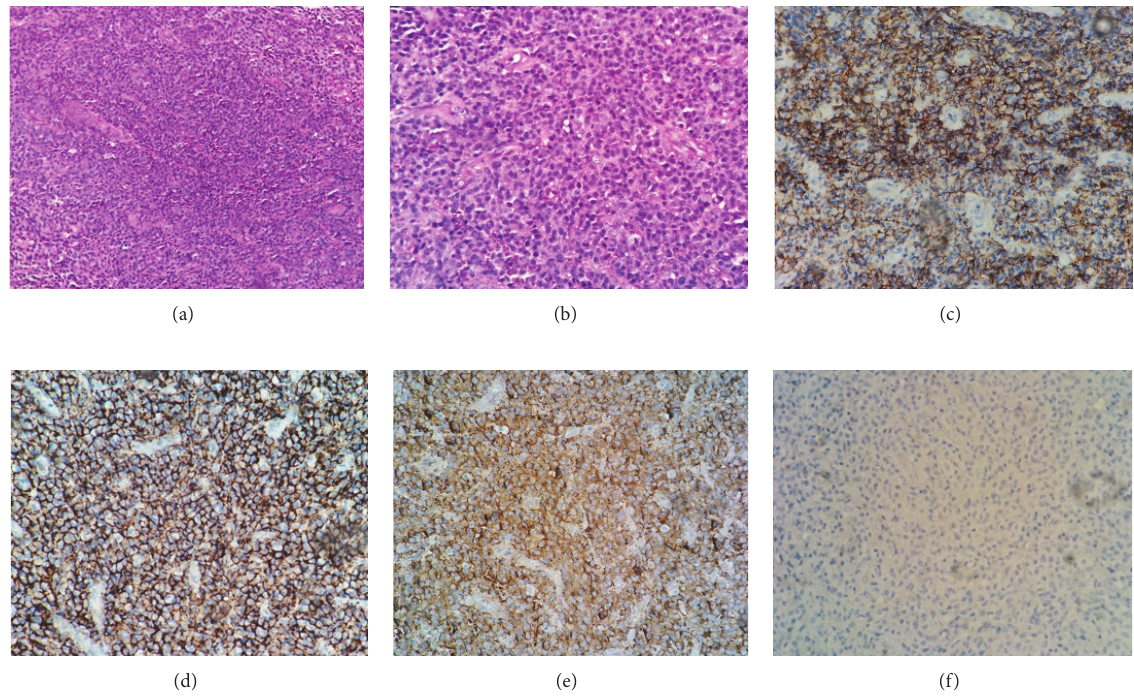
Figure 2: Histological analysis of the bone lesion in the body of T12. (a) The micrograph shows the accumulation of plasma cells with the destruction of trabecular bones [hematoxylin and eosin (H&E) staining; magnification, × 200]. (b) Higher magnification of the image in (a) (H&E staining; magnification, × 400). Immunohistochemical staining shows positive expression of (c) CD38 (++), (d) CD138 (++), (e) lambda (++), and (f) kappa ( − ) (magnification, × 400).